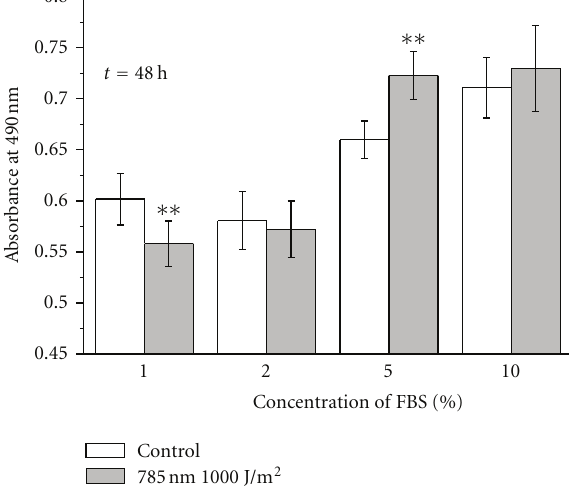
Figure 5: The proliferation of HeLa cells in di ff erent FBS concen- trations (laser wavelength λ = 785 nm, energy density 1000 J/m 2 , irradiation time 100s). The absorbance value was assessed at 48 h after laser irradiation. Error bars were from three independent experiments, ∗∗ P < 0 .